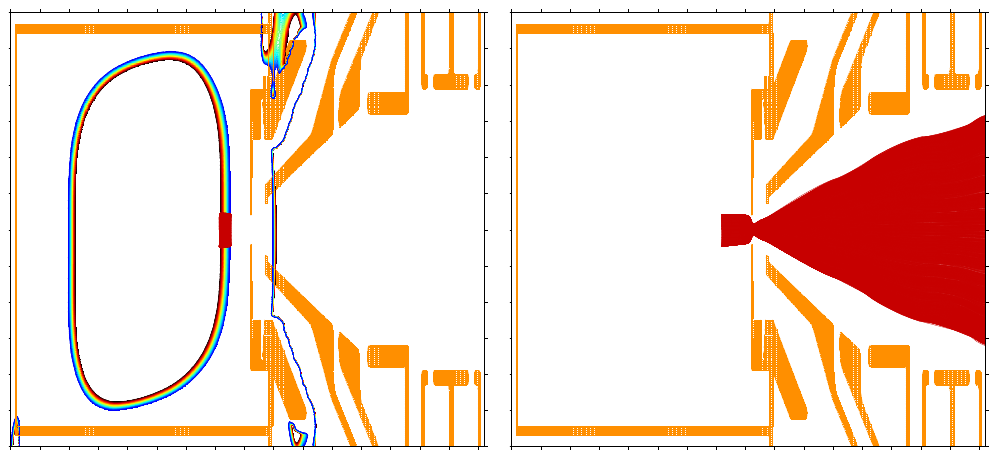
Figure 7. Initial conditions for ions created along a magnetic field line when B is between 1.0 T and 1.1T. Left: lines of constant B for that range are shown here instead of field lines. Red points indicate the starting points for trajectories. Right: only the region of first intersection of constant B and a field line is used here. Assuming such a distribution of ions in front of the extraction system, a nice beam can be simulated, but it does not represent the